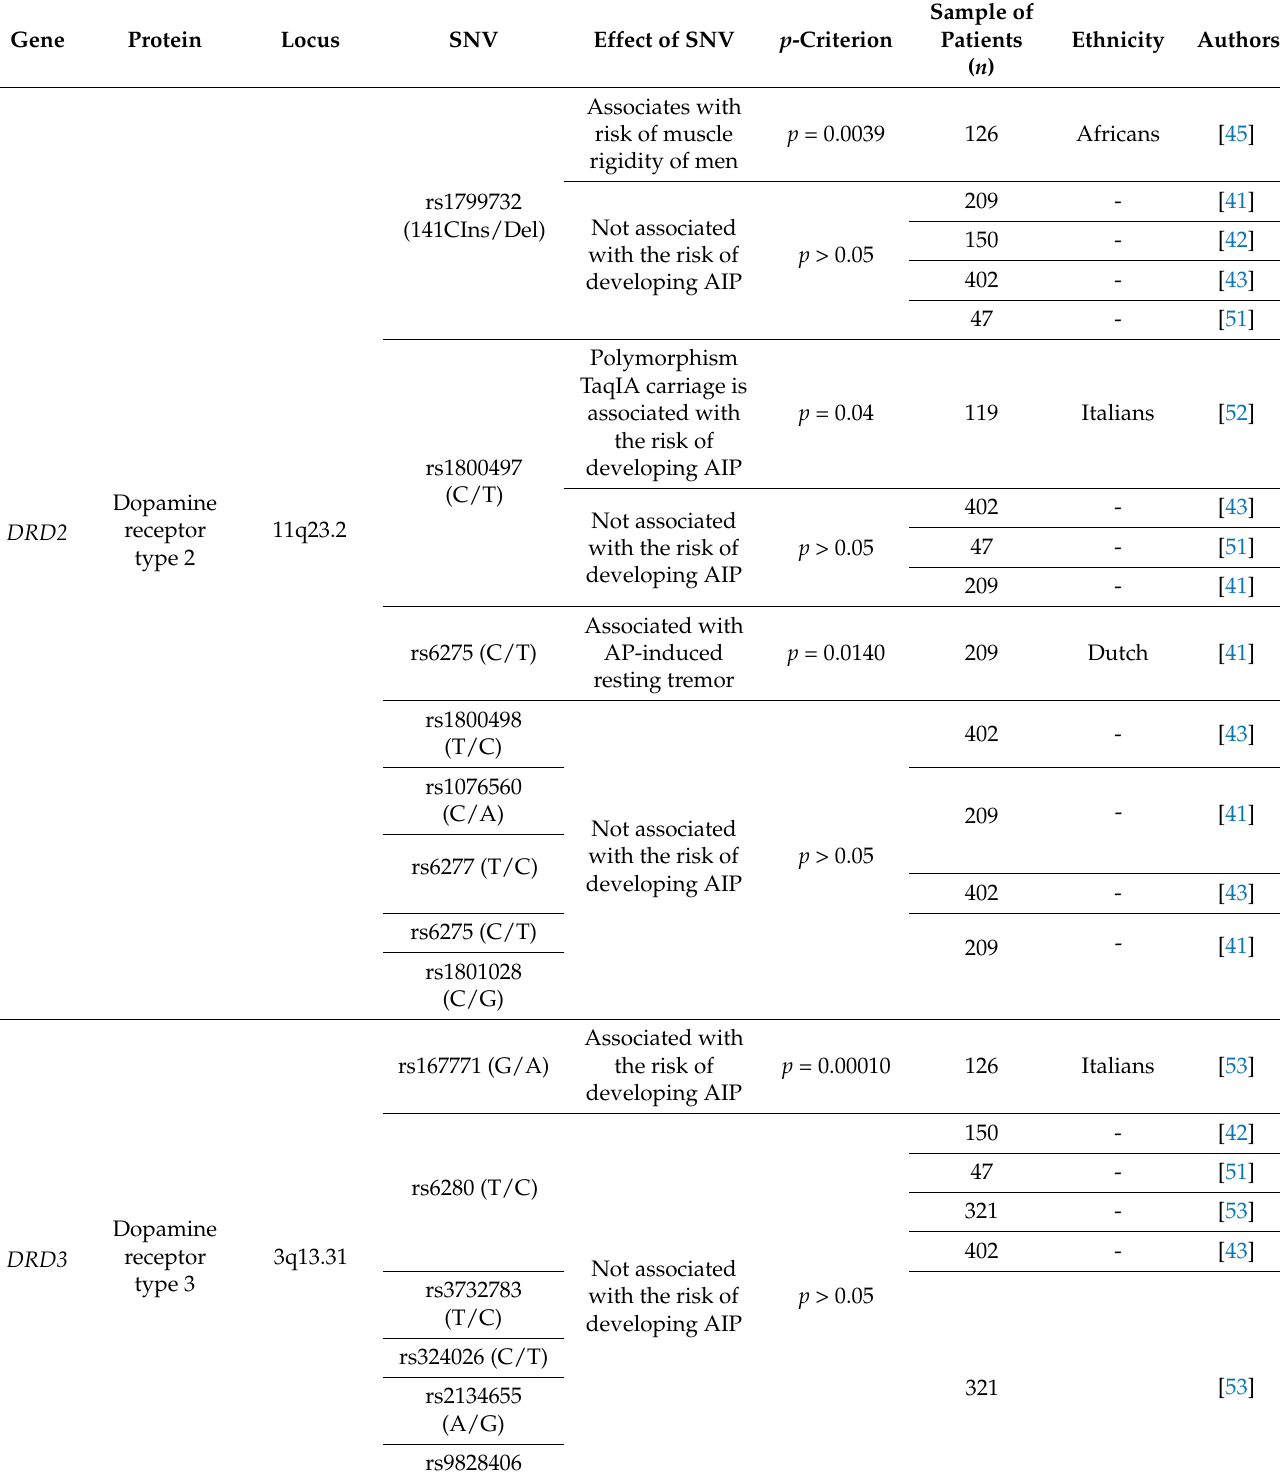
Table 3. Candidate genes encoding dopamine receptors and predisposed to development of antipsychotic-induced